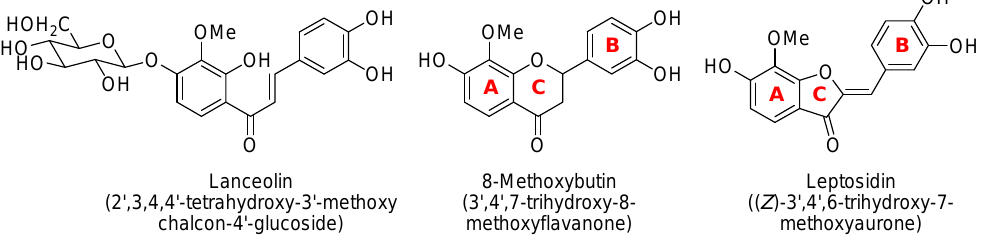
Figure 1. Isolated flavonoids from Coreopsis lenceolata L. petals.